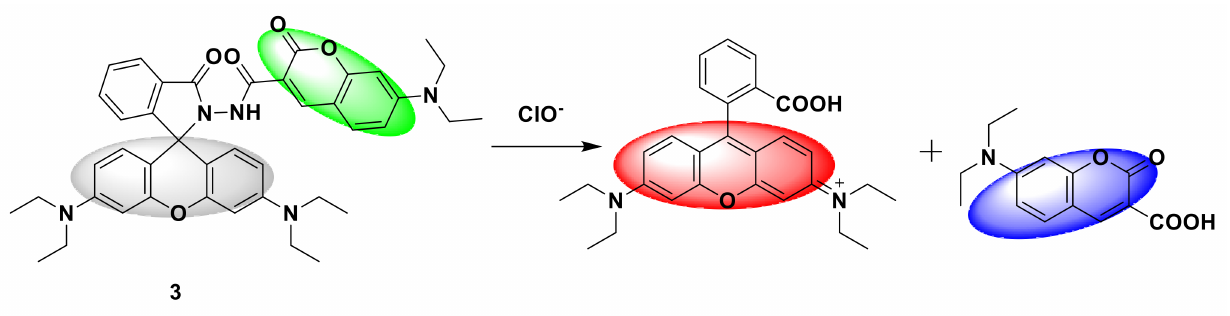
Figure 4. The reaction of probe 3 and ClO −